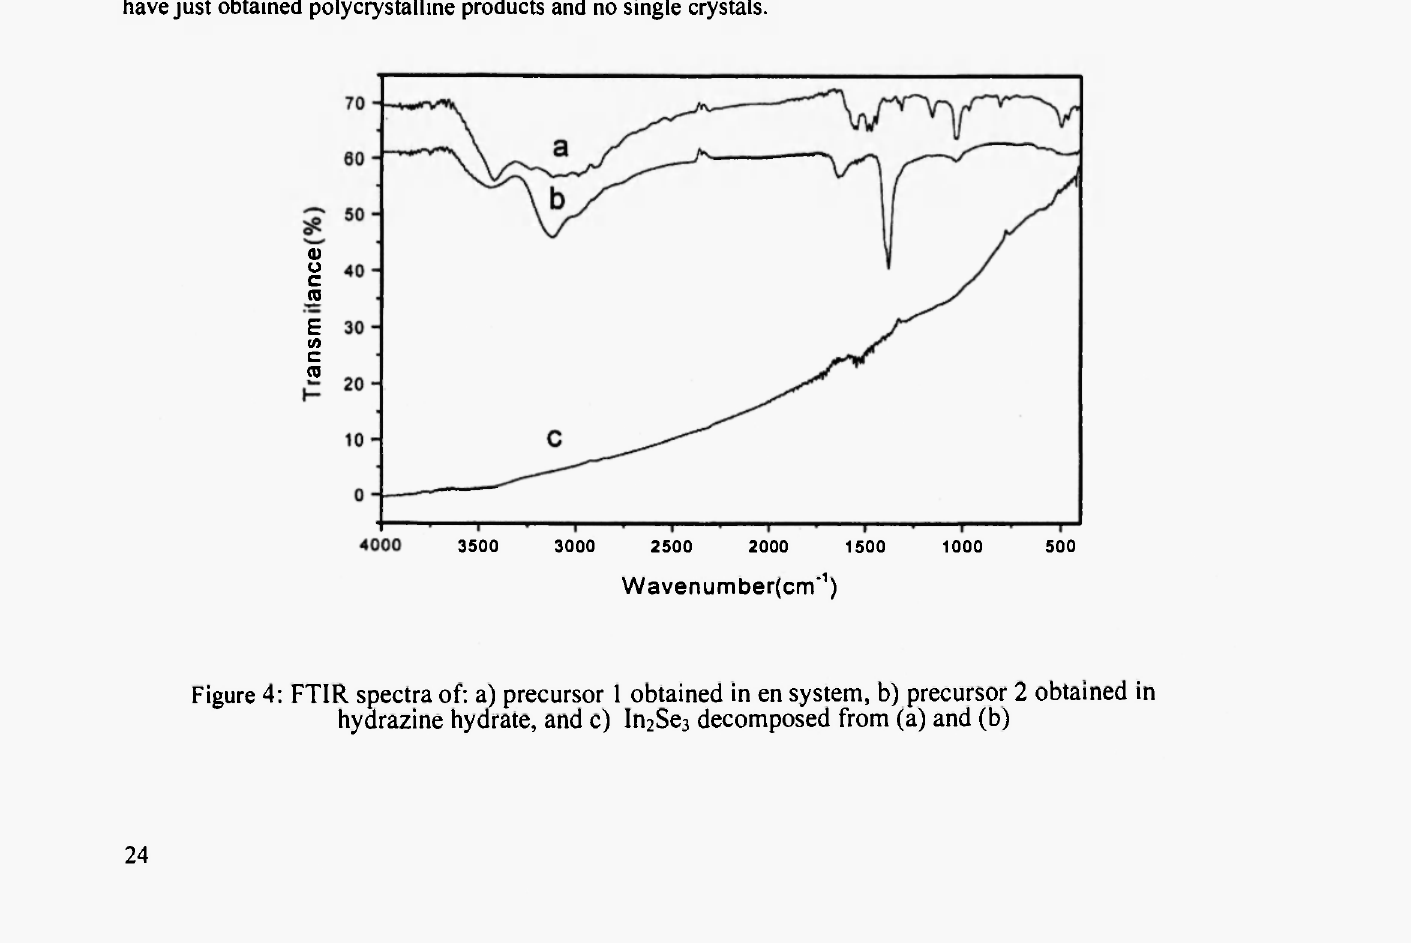
Figure 3: Transmission electron microscopy (TEM) of In^Se^ d e c o m p o s ed from: a) precursor 1 in en system,(magnification = 1 . 0 x l 0 4 ) a nd bj precursor 2 in h y d r a z i ne hydrate system(magnification = 3 . 0 x 1 0 4 )